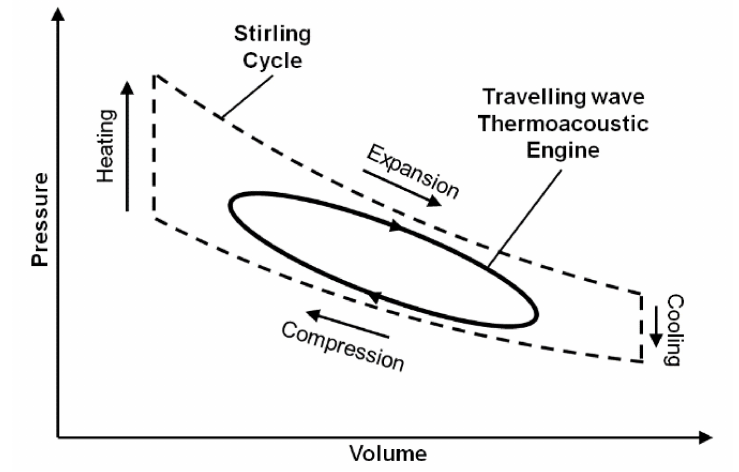
Figure 11. Thermoacoustic engine pressure-volume operating cycle versus Stirling cycle [97].